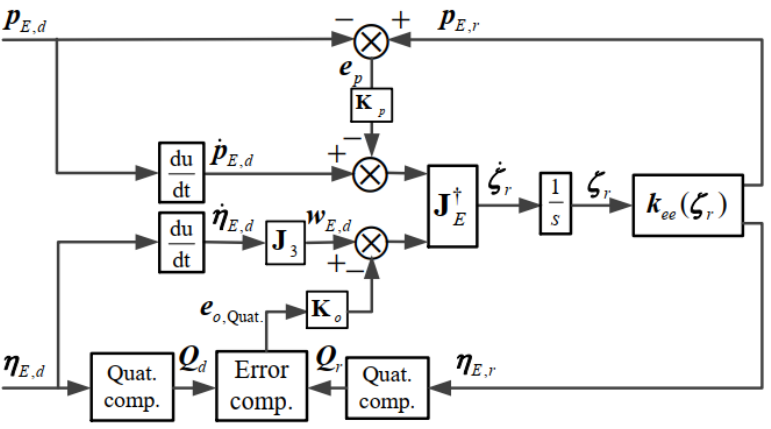
Figure 2. The quaternion-based CLIKA of the UVMS.